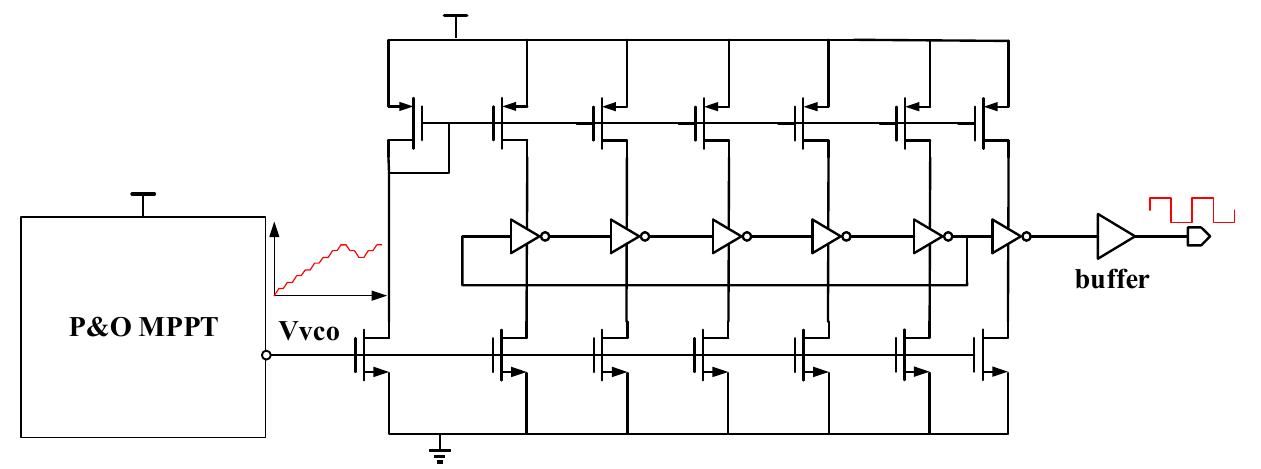
Figure 13. The circuit of the current-hungry voltage control oscillator.